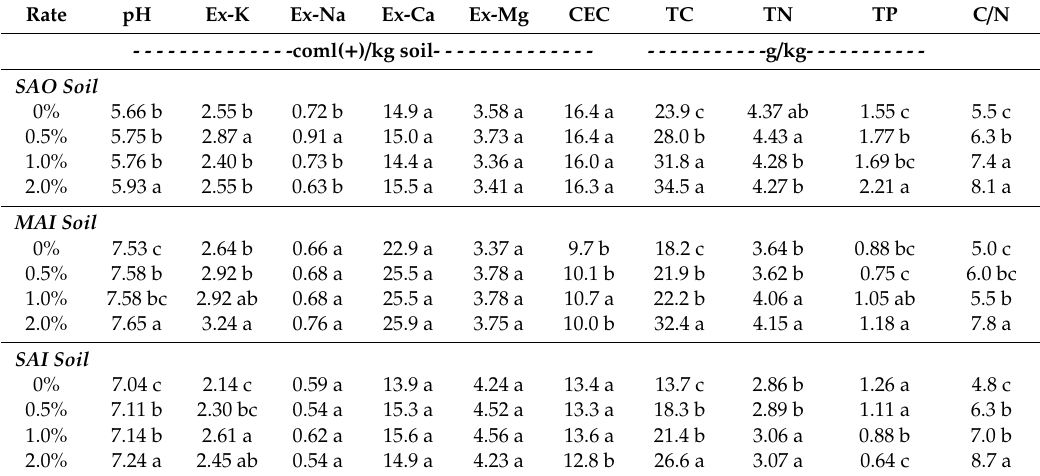
Table3. Meanvaluesoftotalsoilcarbon(TC),nitrogen(TN),andphosphorus(TP),soilpH,exchangeable bases (K, Na, Ca, and Mg), and cation exchangeable capacity (CEC) of four treatments of three soils after 434-day incubations 1